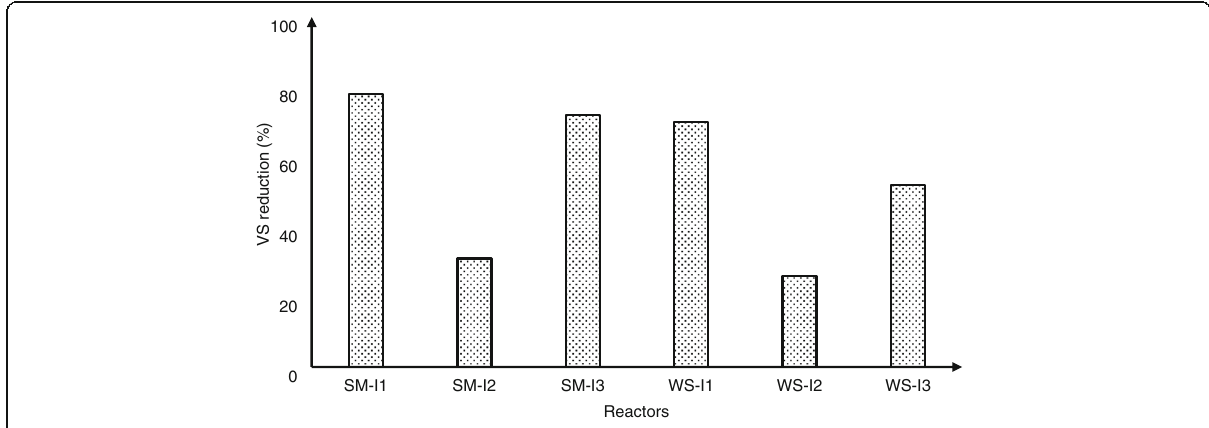
Fig. 3 VS removal from SM and WS inoculated with different